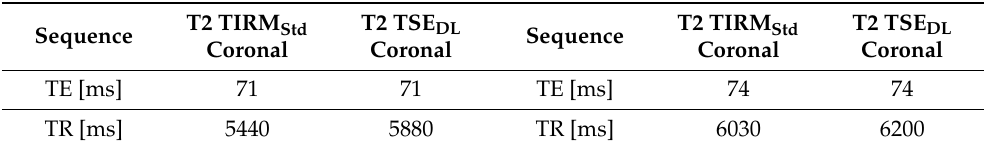
Table 1. Acquisition parameters for lower extremities at 1.5 T and 3